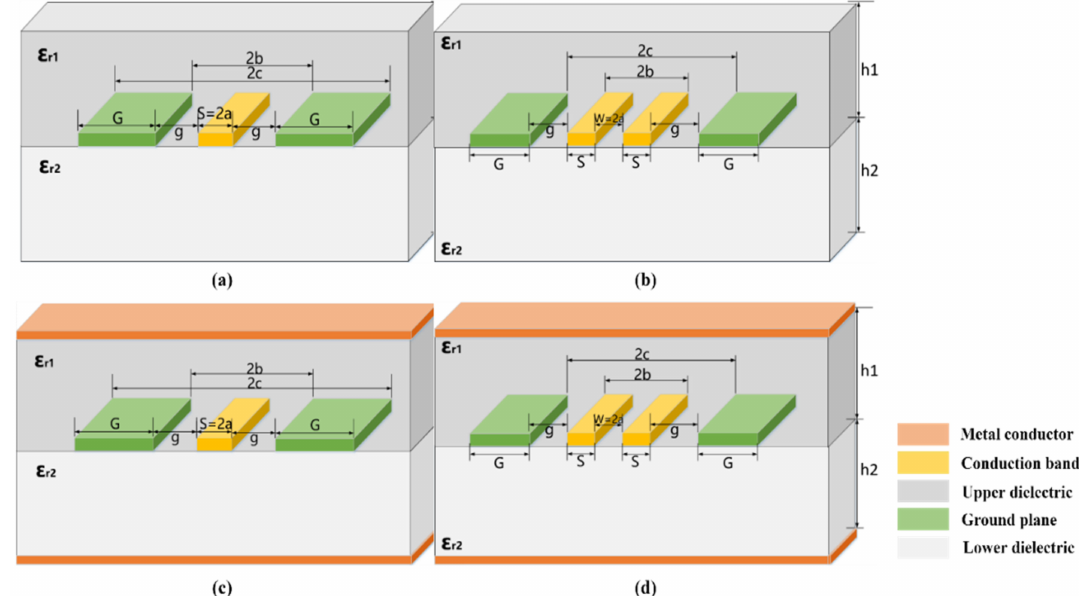
Figure 4. ( a ) Diagram of traditional coplanar waveguide structure; ( b ) schematic diagram of traditional differential coplanar waveguide structure; ( c ) single-ended strip coplanar waveguide structure diagram with upper and lower metal plates; ( d ) differential strip coplanar waveguide structure diagram with upper and lower metal